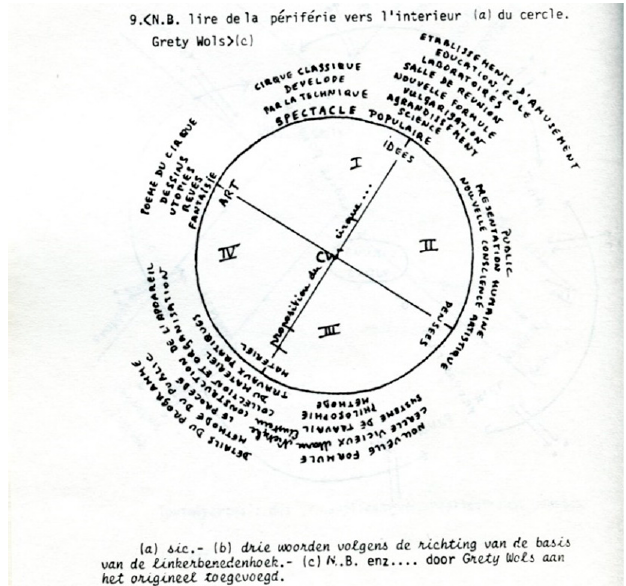
Figure 5. Wols, Circus Wols circle , September 1940. Archives Wols, portfolio Circus Wols . Transcription Claire Van Damme, 1985. Used with permission/Courtesy Claire Van Damme.